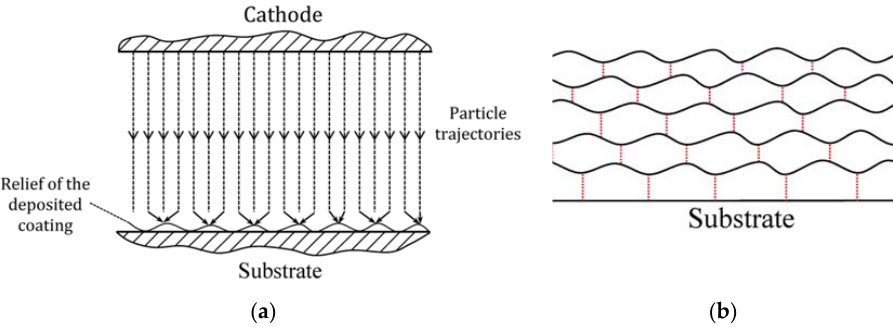
Figure 7. Diagram for ( a ) the formation of the relief of the coating being deposited; ( b ) the predicted cracking for the multilayer